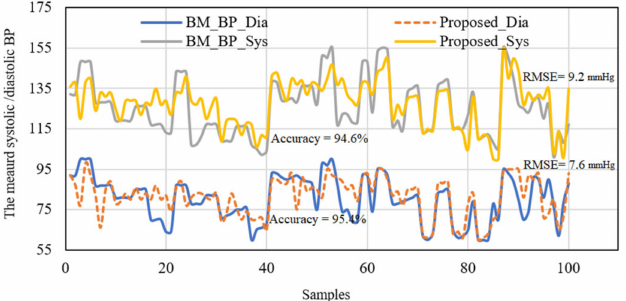
Figure 6. The systolic and diastolic BP comparison between the proposed imaging system and BM